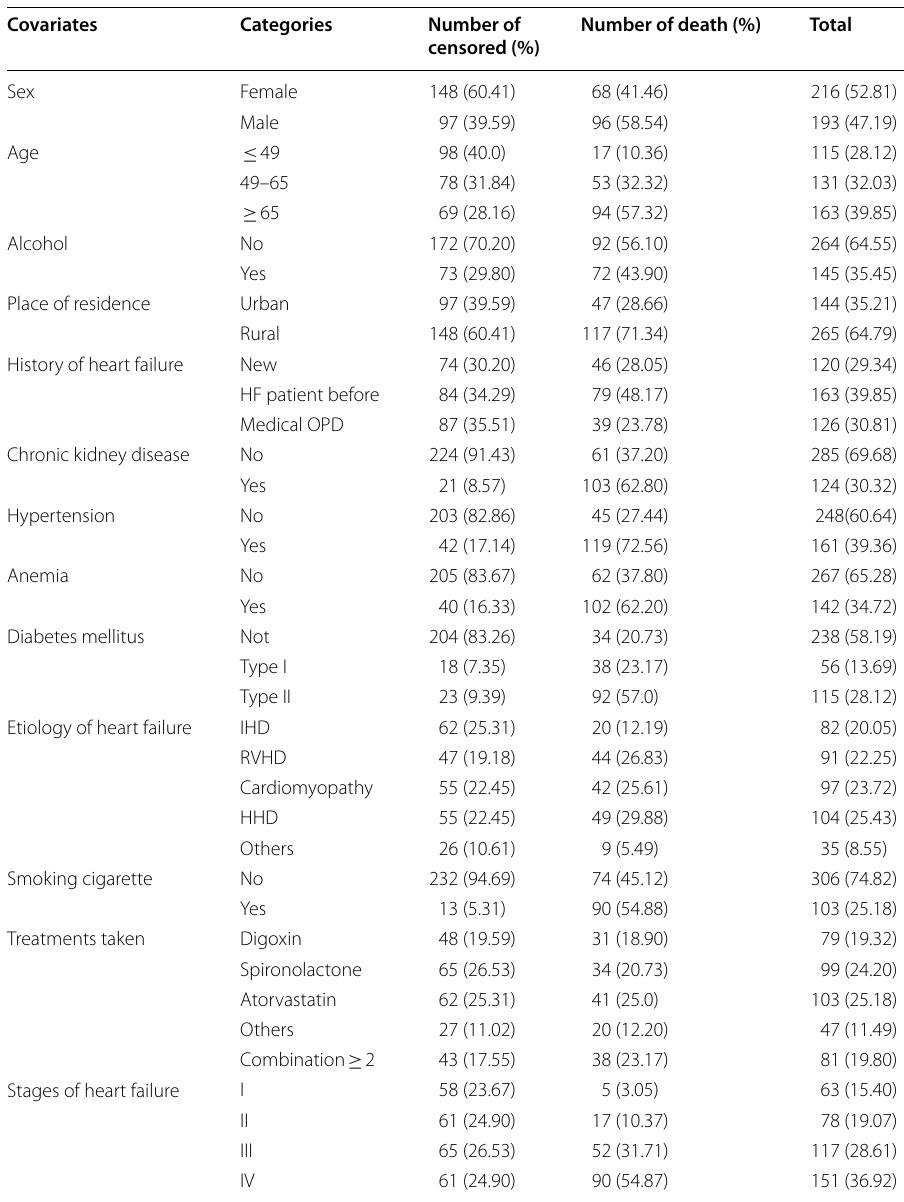
Table 4 Descriptive summaries of patient’s for HF data set